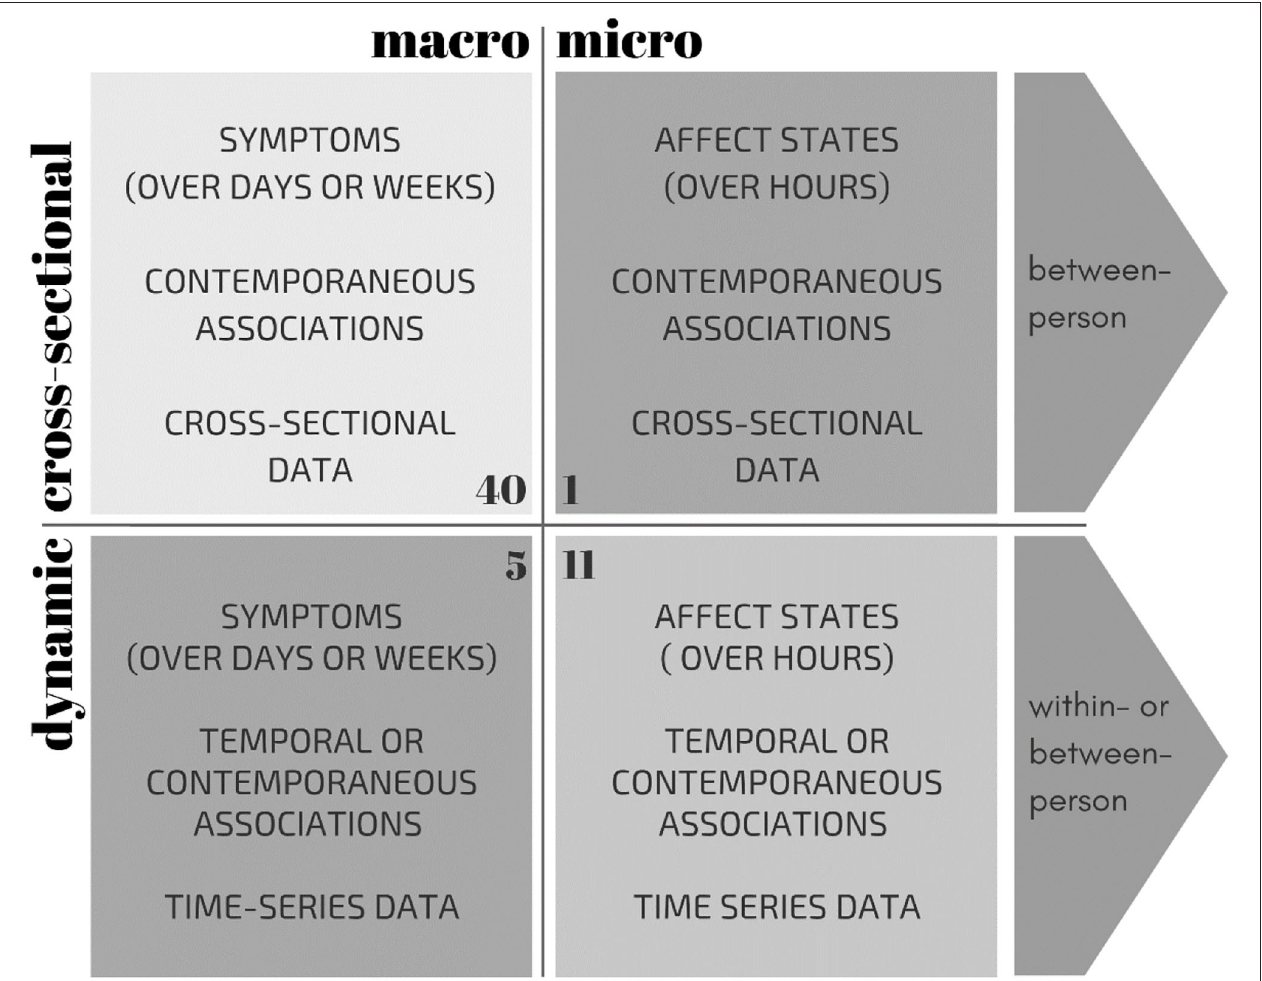
FIGURE 1 | Overview of characteristics of the four methodological approaches to network theory: micro-level affective states vs. macro-level symptoms, based on cross-sectional vs. dynamic (time-series) data. The number of studies are indicated in the corner of each quadrant (total N = 56). Note that one study constructed both a cross-sectional and a dynamic network, and is therefore referenced twice in this